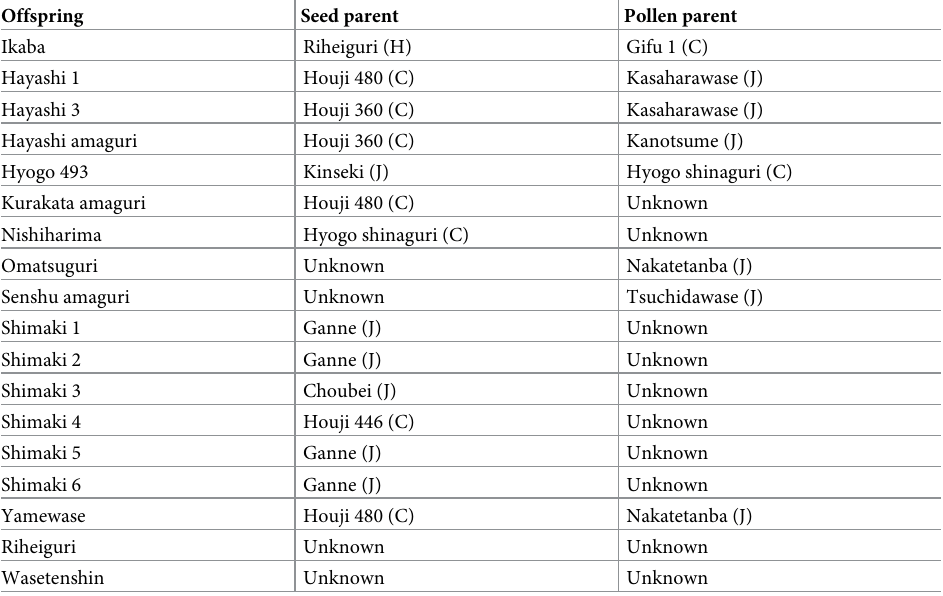
Table 4. Putative parent–offspring relationships for Japanese–Chinese hybrid cultivars.